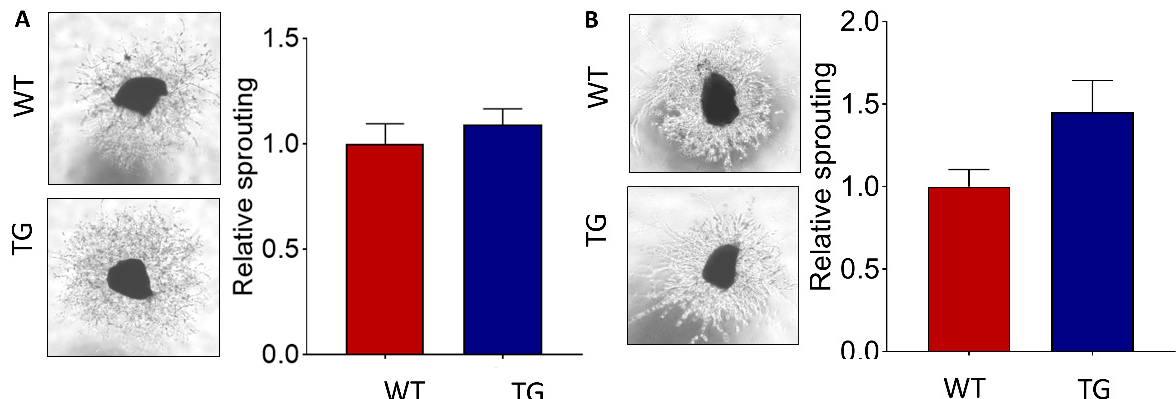
Figure 9. HtrA1 increased choroidal angiogenic potential of CAG-HtrA1 Tg mice. The choroid sprouting assay enables analysis of the relationship between choroidal endothelial cells and RPE allowing for the discovery of mechanisms that control choroidal vascularity to sub-retinal proliferative disorders. ( A , B ) Representative images and quantitative analysis of vessel outgrowth from P3 choroid from P3 mice ( n = 3) and 52-week-old mice ( n = 2) of CAG-HtrA1 Tg and wild-type controls. Although there was no difference in the choroidal sprouting using the postnatal day 3 choroidal explants, choroidal explants from aged CAG-HtrA1 Tg mice showed an increased relative sprouting area than the wild-type mice. ImageJ software was used to quantify this assay by counting the number and length of sprouting vessels.